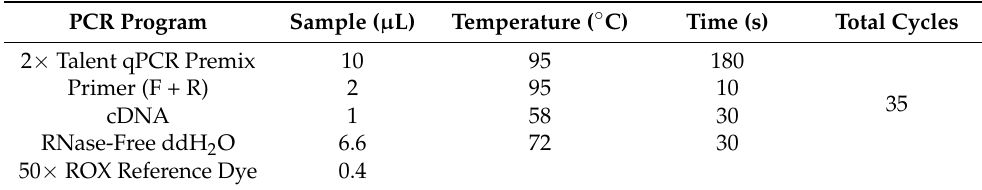
Table 1. Quantitative RT-PCR reaction solution and program